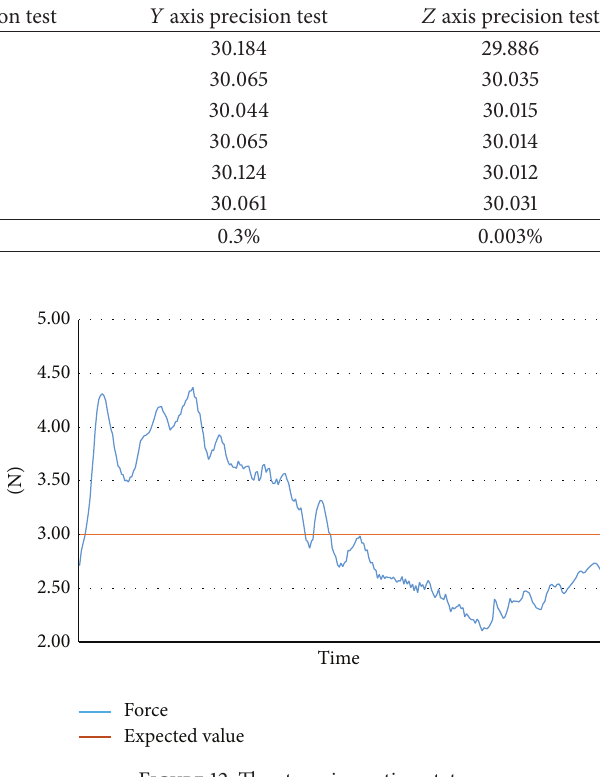
Figure 12: The stress in motion